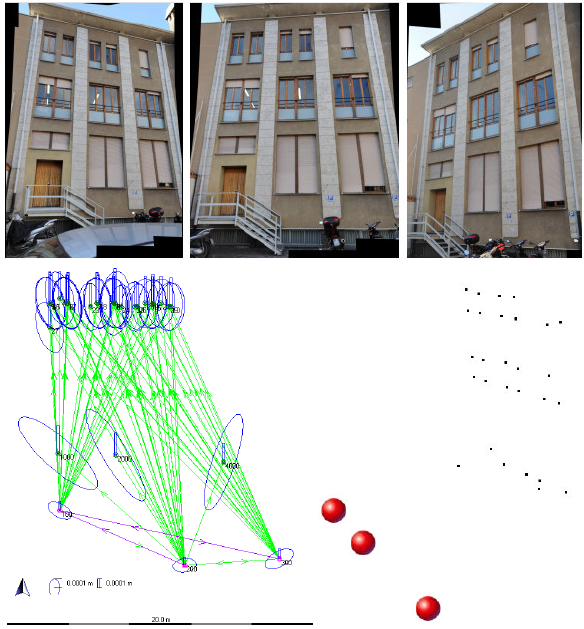
Fig. 6. Projections, geodetic network with error ellipses (targets, image locations and stations), and 3D view of projection poses.